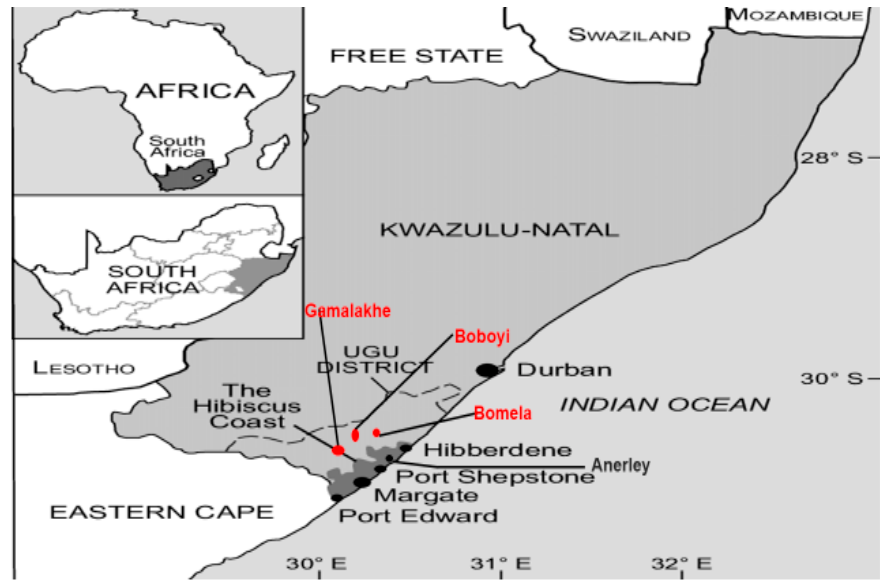
Figure 1. Map showing the study area at Ugu District Municipality, KwaZulu-Natal Province, South Africa.